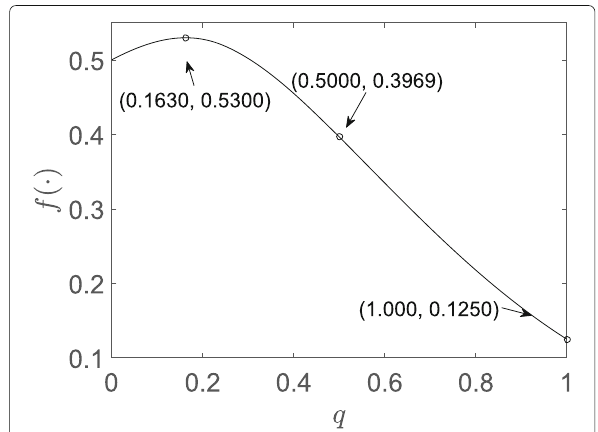
Fig. 4 Plot of f ( · ) (given in (9)) with respect to q from 0.001 to 1 with step size 0.001. One can easily find that the function f ( q ) obtains its maximum (around 0.5300) at about q = 0.16 and its minimum value (around 0.125) at q = 1. Besides, when q = 0.5 the value of f ( q ) is around about 0.3969. In other words, f ( q ) ≥ f ( 1 ) for any q ∈ ( 0,1]